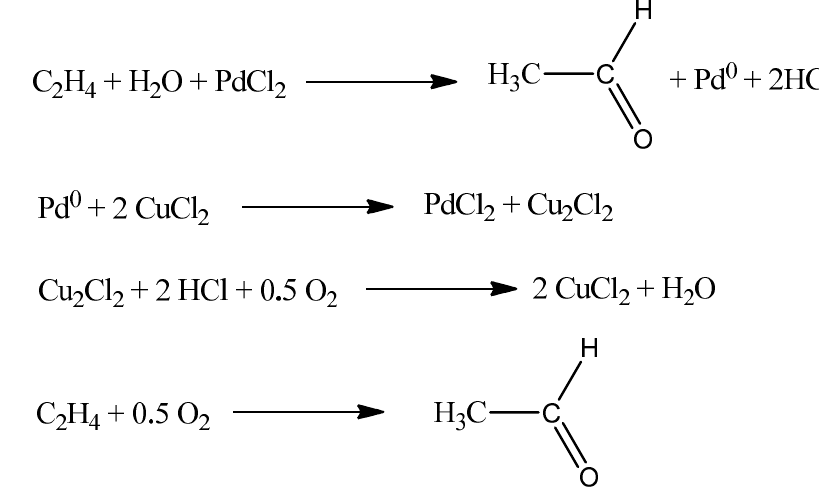
Figure 1. Reactions forming the catalytic cycle of the Wacker process [1].